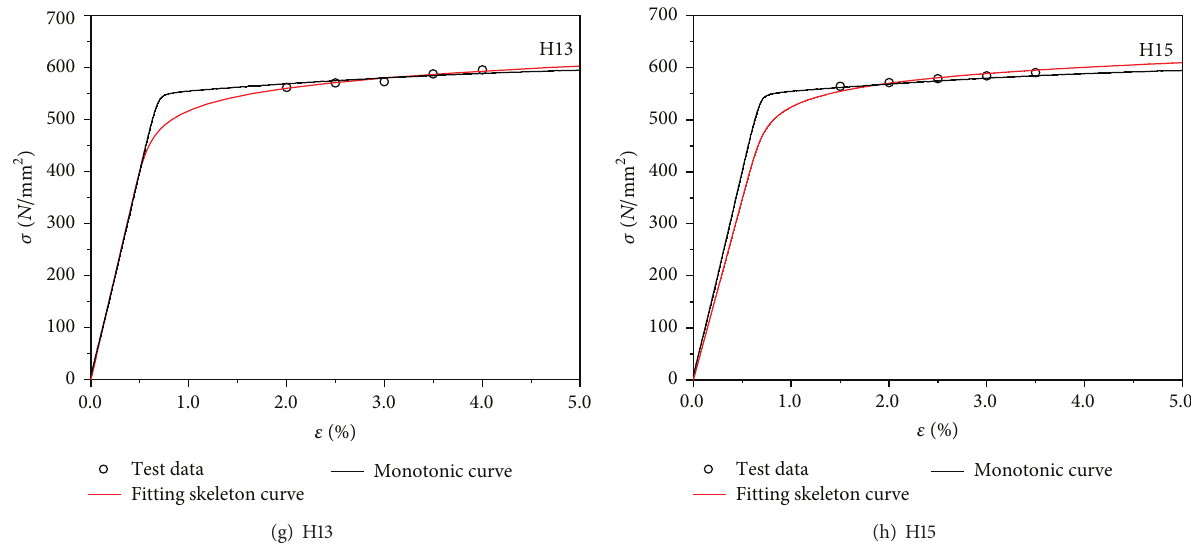
Figure 7: The comparison between cyclic skeleton curves and monotonic loading curves. Table 5: Parameters of 7A04 aluminum alloy in the combined model.